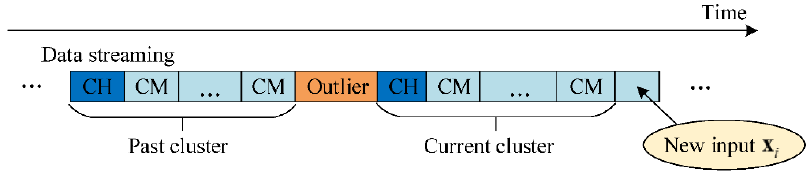
Figure 2. Clustering structure of data streaming clustering in D-CLU algorithm. For a new input